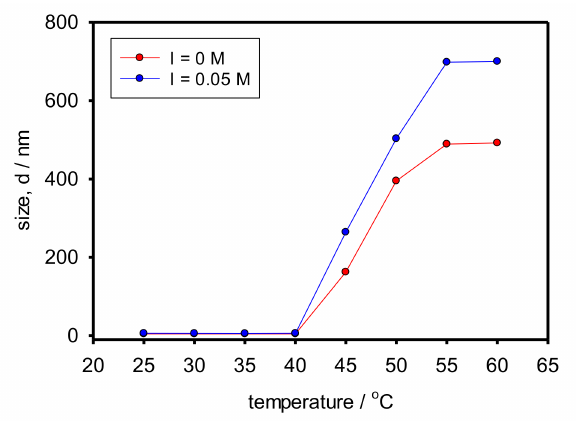
Figure 4. Evolution of the hydrodynamic diameter of Cop-48/6 with the temperature both with and without added salt.